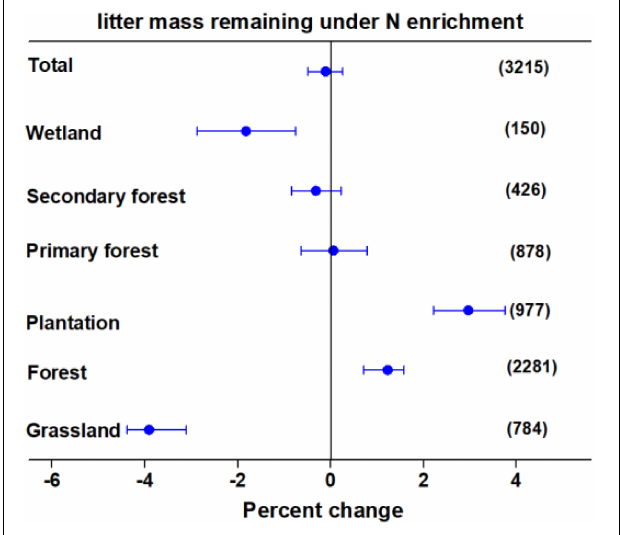
FIGURE 1 | Mean percent change in litter mass remaining after nitrogen (N) enrichment among different ecosystem types. Differences in mean levels were regarded as significant if the 95% confidence intervals (CIs) did not overlap zero. Values in brackets represent the number of observations for each ecosystem